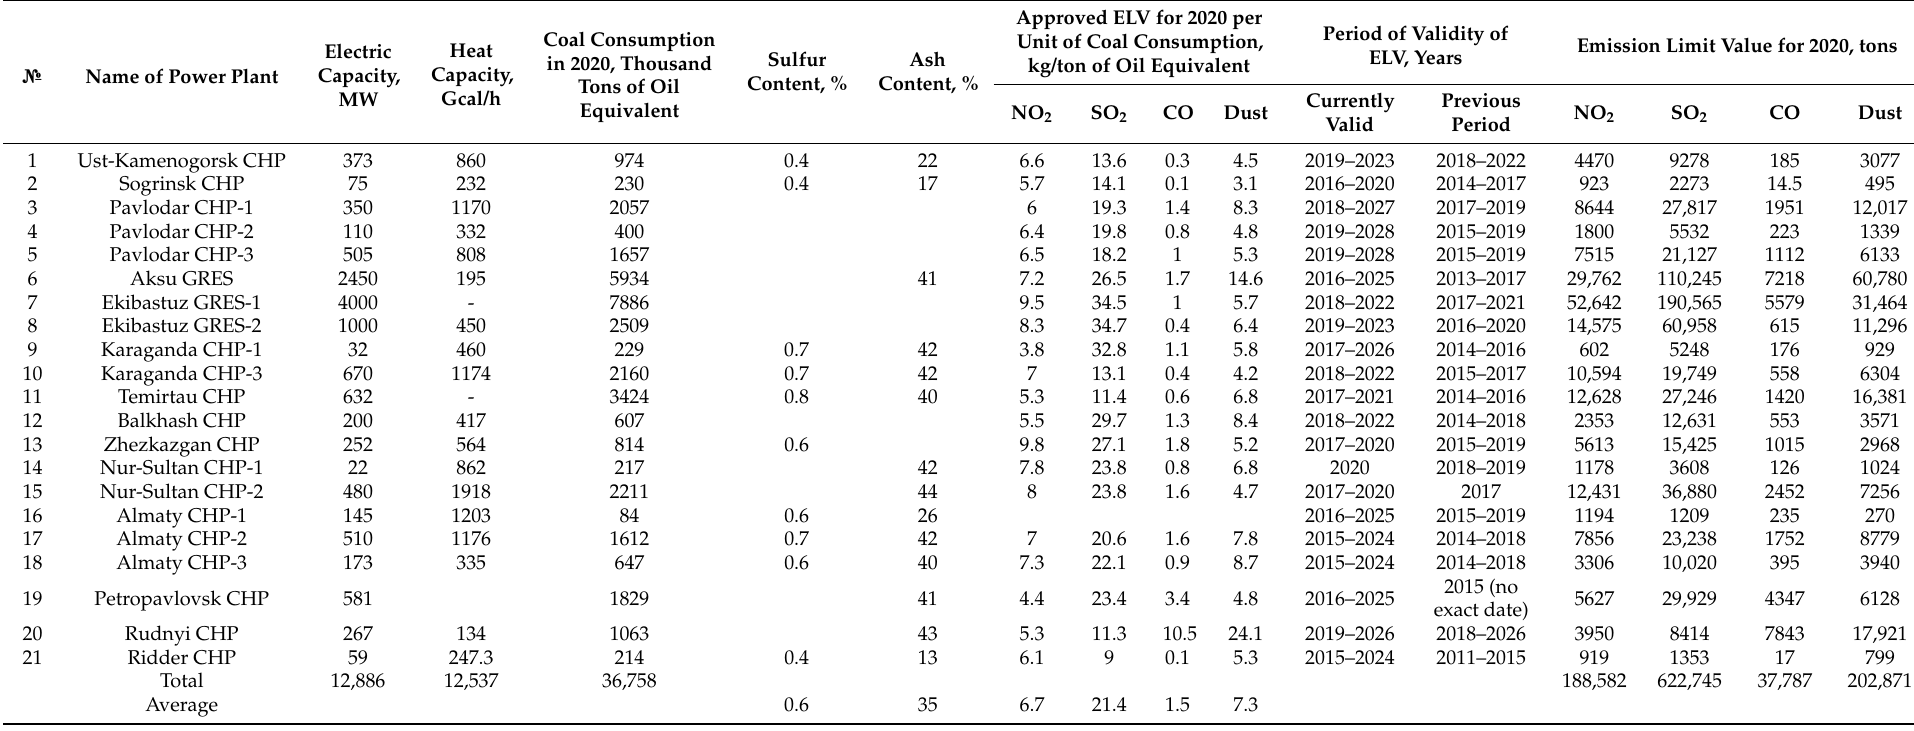
Table A1. Information from approved ELV for selected power